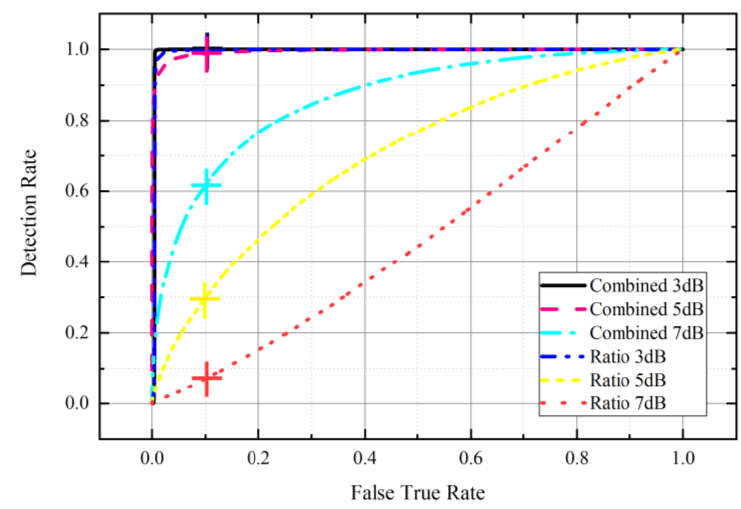
Figure 11. The ROC of Ratio and the Combined Method of Improved Ratio and 𝐶/𝑁 0 − 𝑀𝑉 .